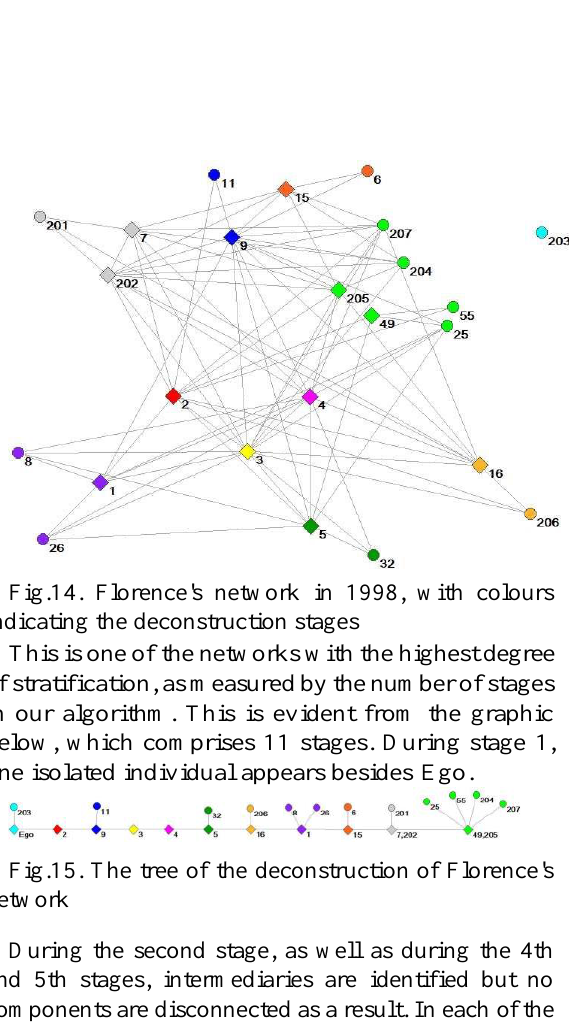
and the final stage disconnects four